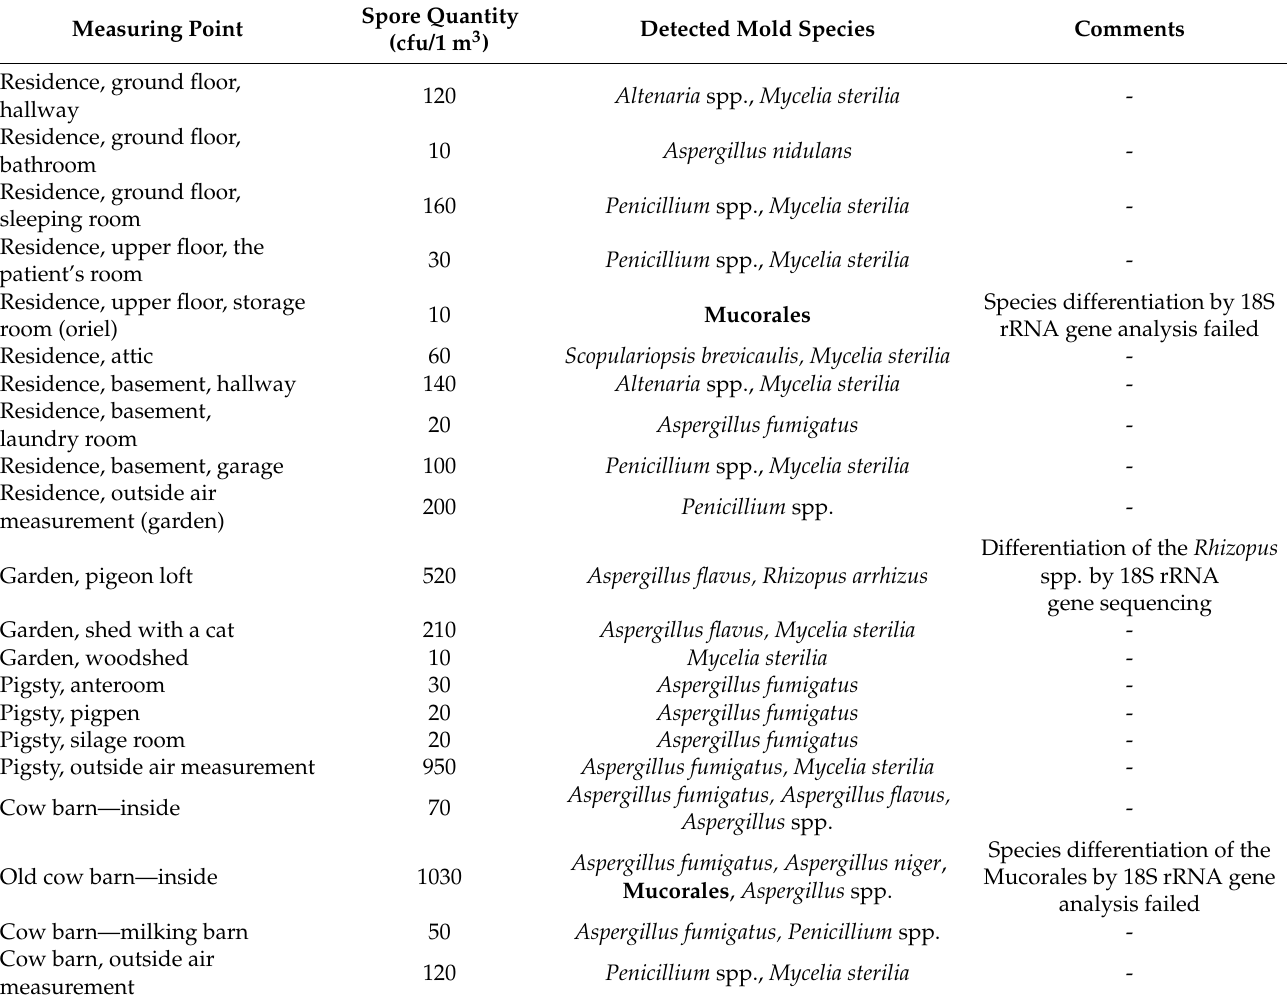
Table 1. Mold detections from the airborne pathogen samples. Due to the nasal colonization of the index patient, Mucorales are indicated in bold